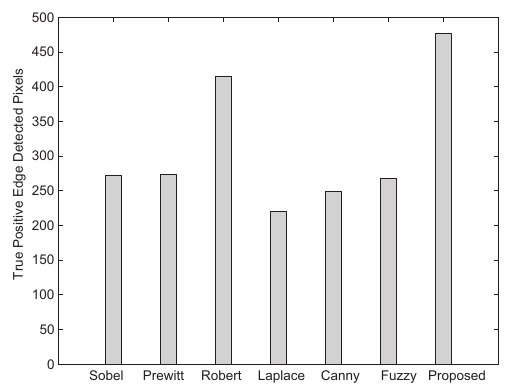
Figure 11. Comparison of true positive edge detected pixels between the proposed algorithm and other conventional